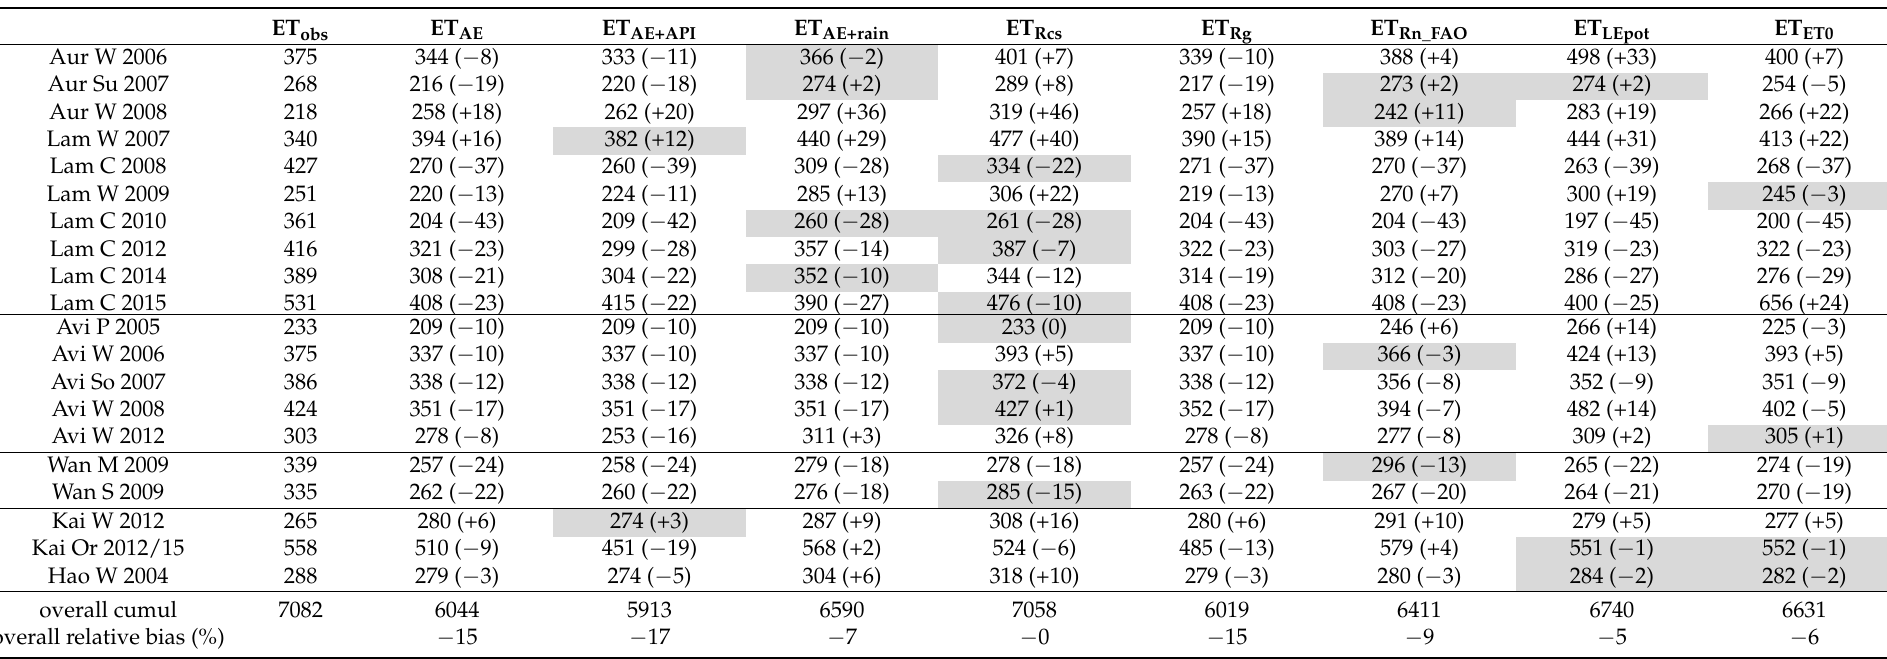
Table A1. Cumulative seasonal evapotranspiration observed (ET obs , mm) and reconstructed (mm) with the different reference quantitiesand error associated (relative bias in %) for the in situ dataset for a revisit frequency of 1 day. The best reference quantityfor each site is